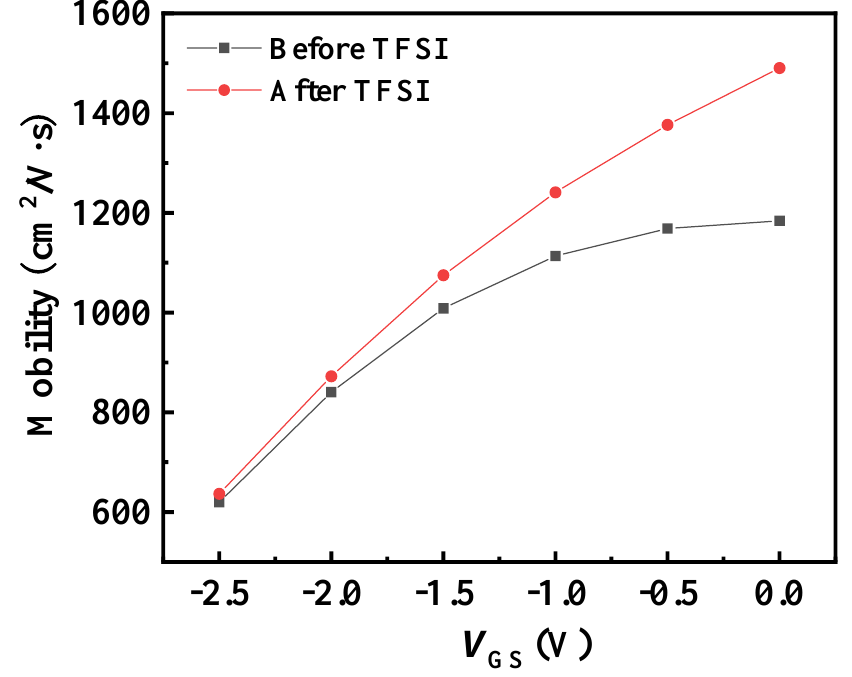
Figure 6. Figure 6. Electron mobility under the gate region of InAlN/GaN HEMT before and after TFSI treat- TFSI ment.